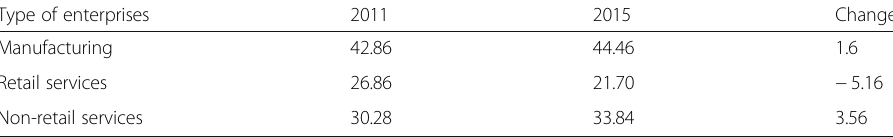
Table 3 Composition of enterprises in the different sectors Type of